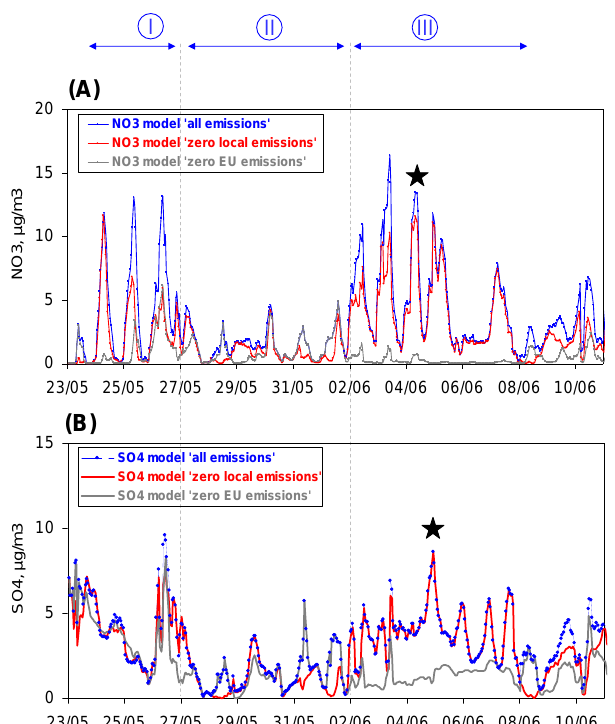
Fig. 11. Model scenarios for fine nitrate (A) and fine sulfate (B) for the reference run (“all emissions” in blue); the scenario with no local (IDF) emissions (“zero local emissions” in red); and the scenario with no European (EU) emissions (“zero EU emissions” in grey). The black star corresponds to the pollution episode (plume case study) depicted in Sect.